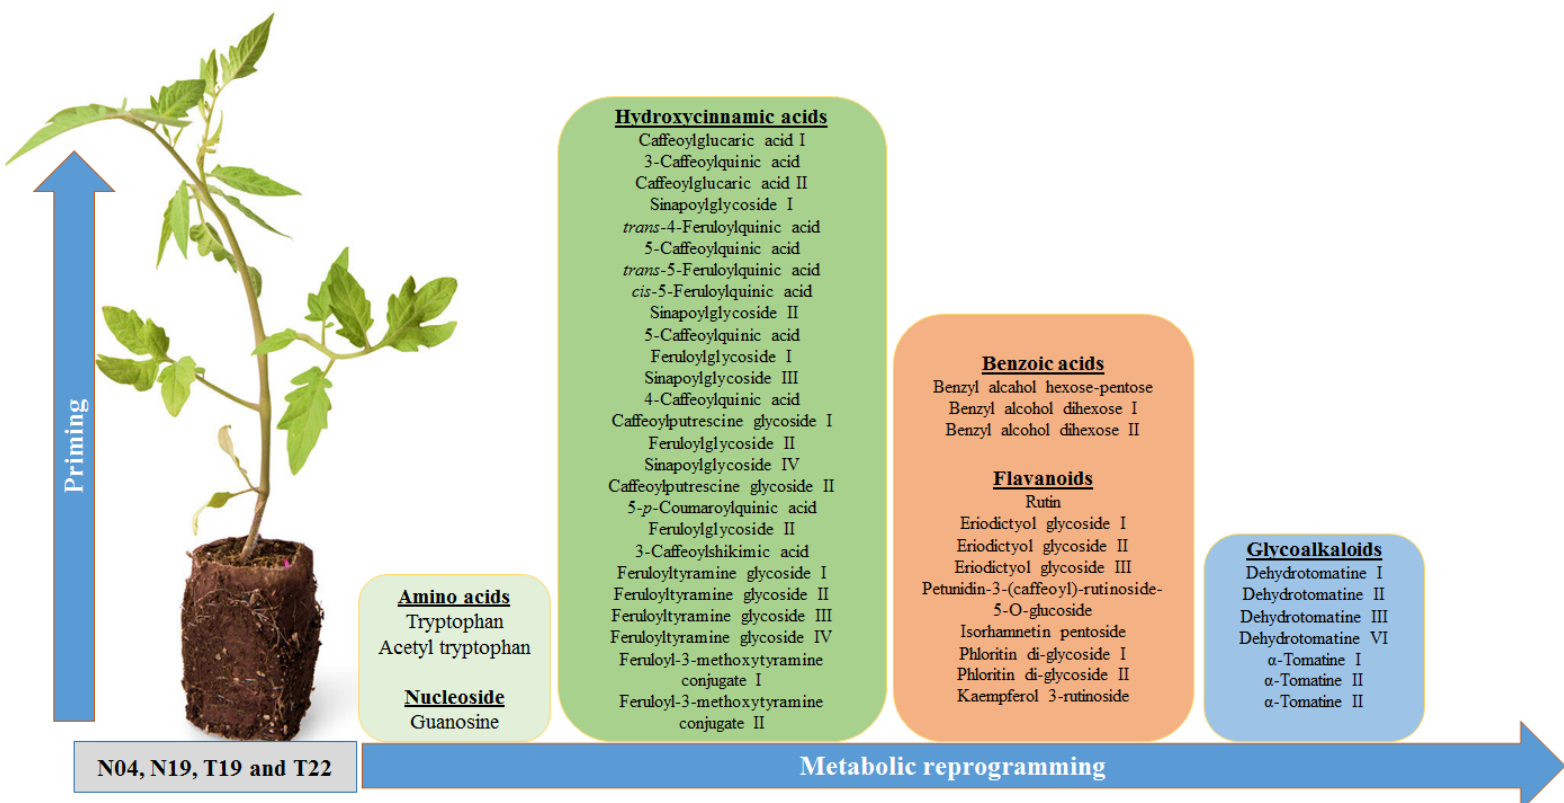
Figure 6. Signatory biomarkers induced by PGPR inoculation of tomato plants. A total of 48 metabolites were found to be differentially reprogrammed due to root inoculation by the different PGPR (N04, N19, T19, and T22). They belong to the metabolite classes of amino acids, nucleosides, various derivatives of hydroxycinnamic acids and benzoic acids, flavonoids and steroidal glycoalkaloids. Even though the plants were inoculated with different PGPR strains, the inoculation lead to activation of similar pathways, but with different metabolic profiles.